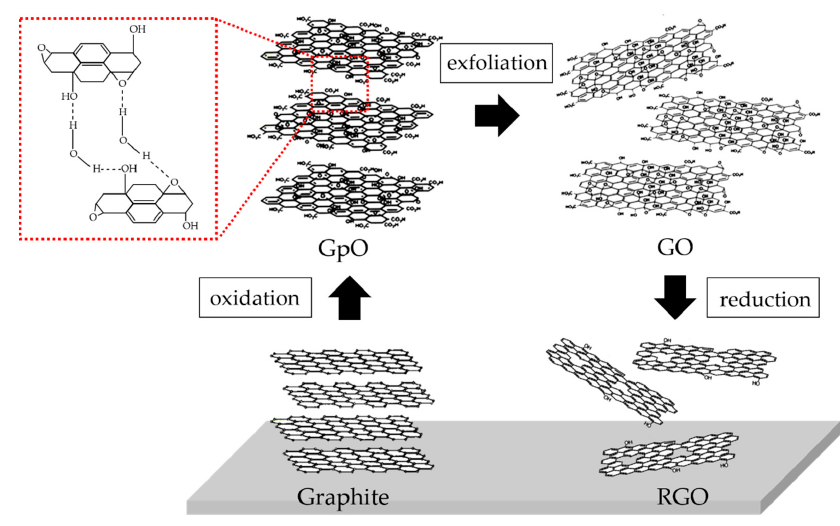
Figure 4. Schematic structure of chemical synthesis based on Lerf-Klinowski model.